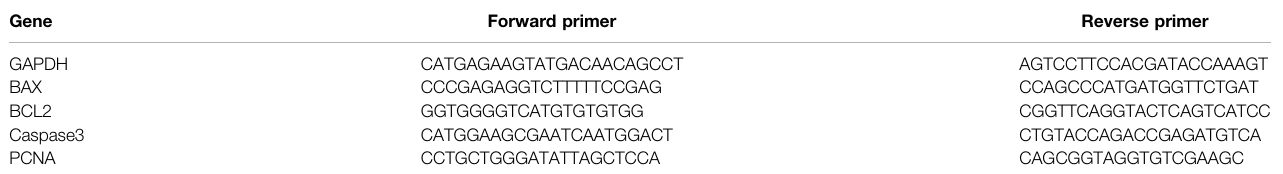
TABLE 1 | The primers used in this study.